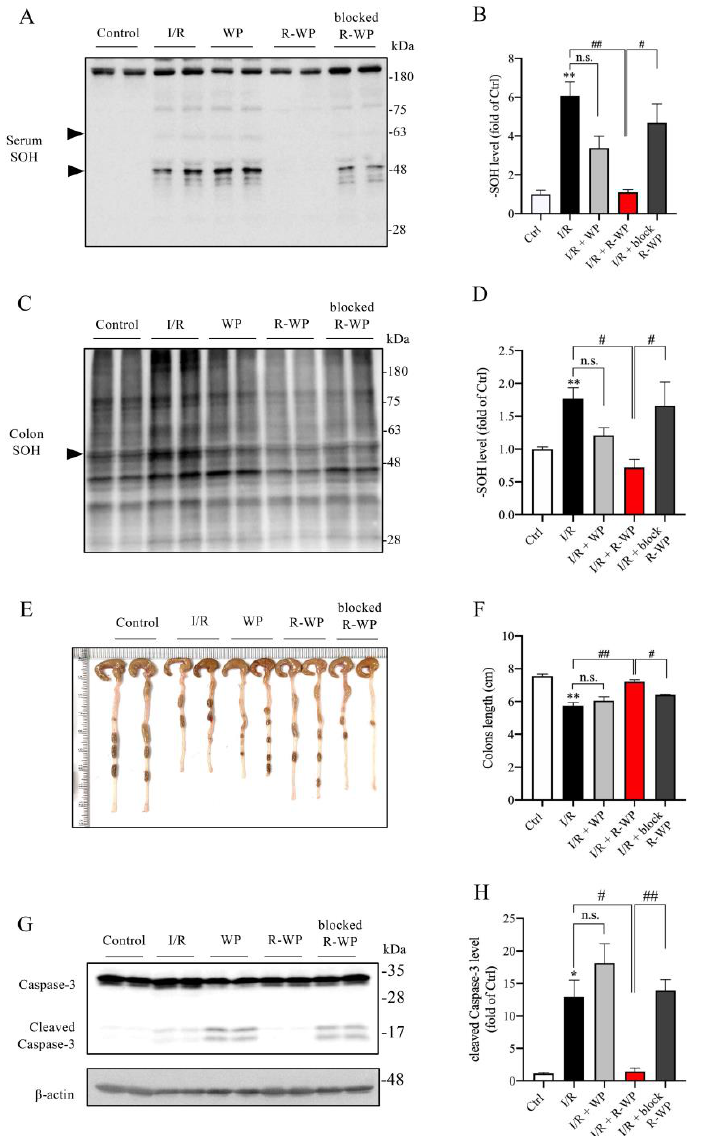
Figure 6. R-WP improves systemic oxidative status in renal I/R mice. ( A – D ) Effect of R-WP treatment on -SOH formation in serum and colon. The serum and colon lysates were assayed for the level of -SOH formation using Western blot, as described in Materials and Methods. The densitometric quantification of the bands (arrowheads in ( A ) and whole blot in ( C )) was performed, and the results are presented as a bar graph in ( B , D ). Data are expressed as mean ± SE ( n = 4; n.s.: not significant; ** p < 0.01 vs. Ctrl; # p < 0.05, ## p < 0.01 vs. R-WP group). ( E , F ) Effect of R-WP treatment on the colon length. Colon lengths at 24 h after the operation were photographed, measured, and presented as a bar graph in ( F ). Data shown are mean ± SE ( n = 4; n.s.: not significant; ** p < 0.01 vs. Ctrl; # p < 0.05, ## p < 0.01 vs. R-WP group). ( G , H ) Effect of R-WP treatment on caspase-3 cleavage in colon tissues. The colon lysates were subjected to Western blot analysis for caspase-3. Note the appearance of cleaved bands at the molecular level around 17 kDa and its prevention by R-WP treatment. Data shown are mean ± SE ( n = 4; n.s.: not significant; * p < 0.05 vs. Ctrl; # p < 0.05, ## p < 0.01 vs. R-WP group).